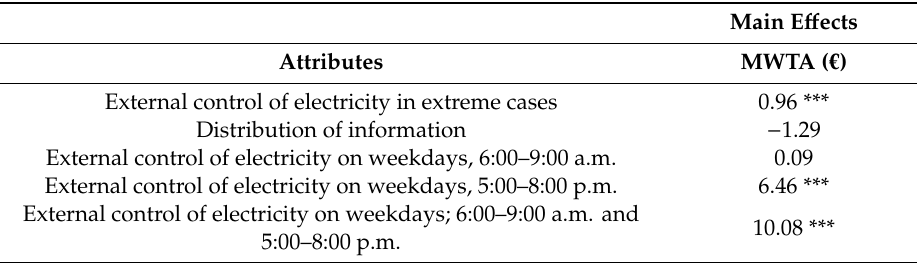
Table A1. Median WTA per month—main e ff